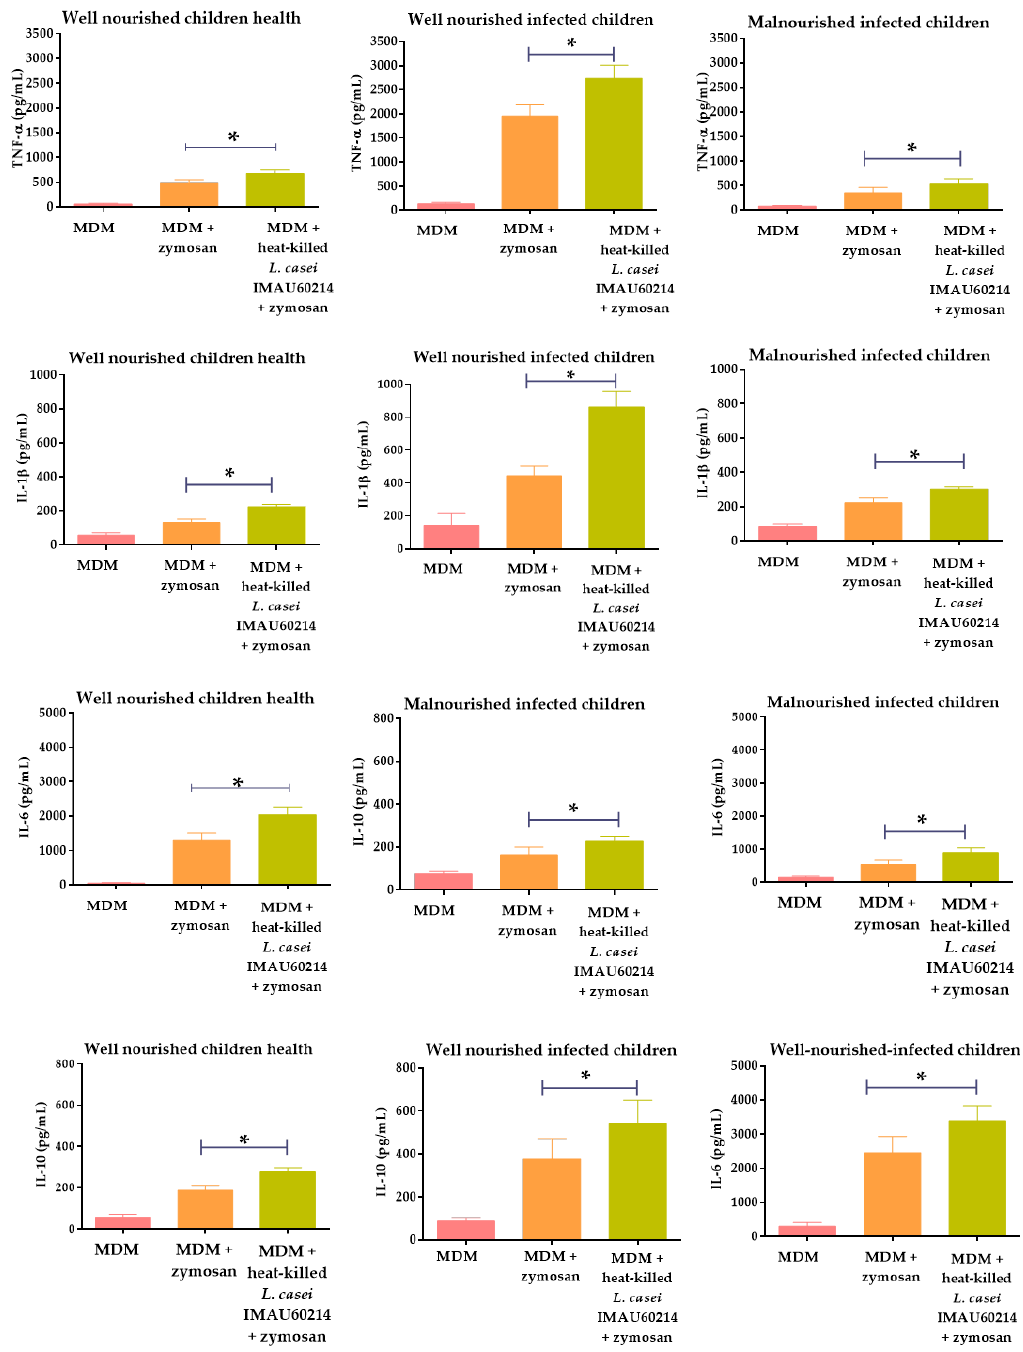
Figure2. E ff ectsofheat-killed L.casei IMAU60214oncytokineproductionbyMDMcells. Theproduction of tumor necrosis factor (TNF- α ), interleukin (IL)-1 β , IL-6 and IL-10 were measured in the supernatant by immunosorbent assay (ELISA). All values are shown as mean ± SD ( n = 15) from duplicate assays from MDM cells with and without pre-treatment of heat-killed L. casei IMAU60214. p -Values were calculated with the Student’s t paired test. * p < 0.05, Significant di ff erences show the change which occurred after pre-treatment with heat-killed L. casei